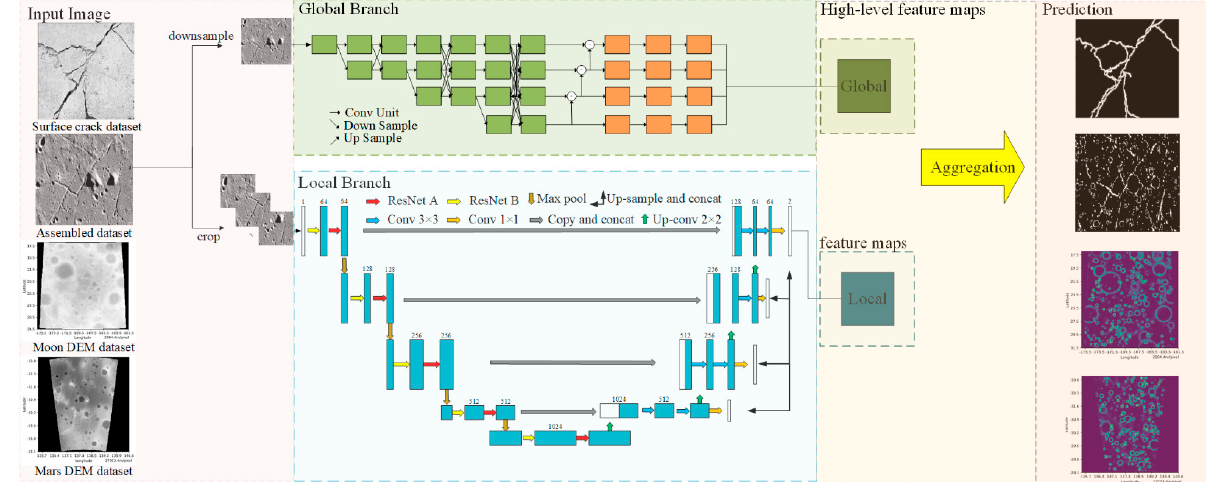
Figure 2. End-to-end automatic lunar feature extraction network based on the HR-GLNet.